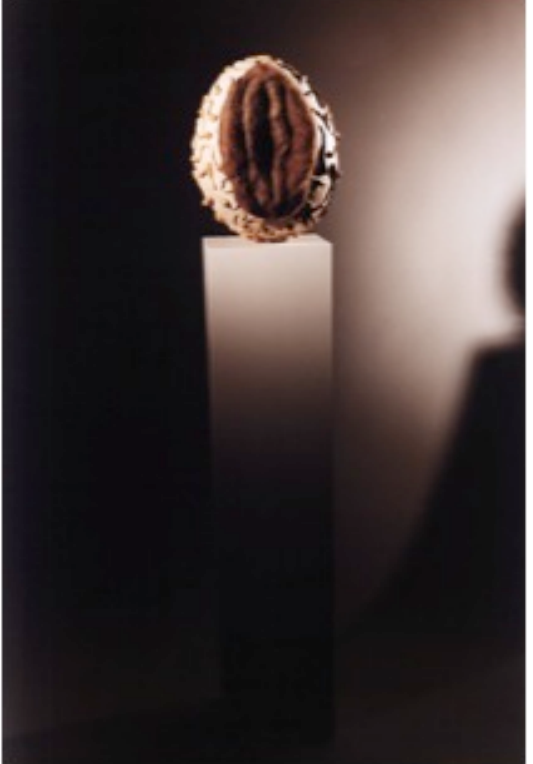
Heather Hanna, A Visual Essay: Interventions and Manipulations in the Maternal Studies in the Maternal, 4(1), 2012,